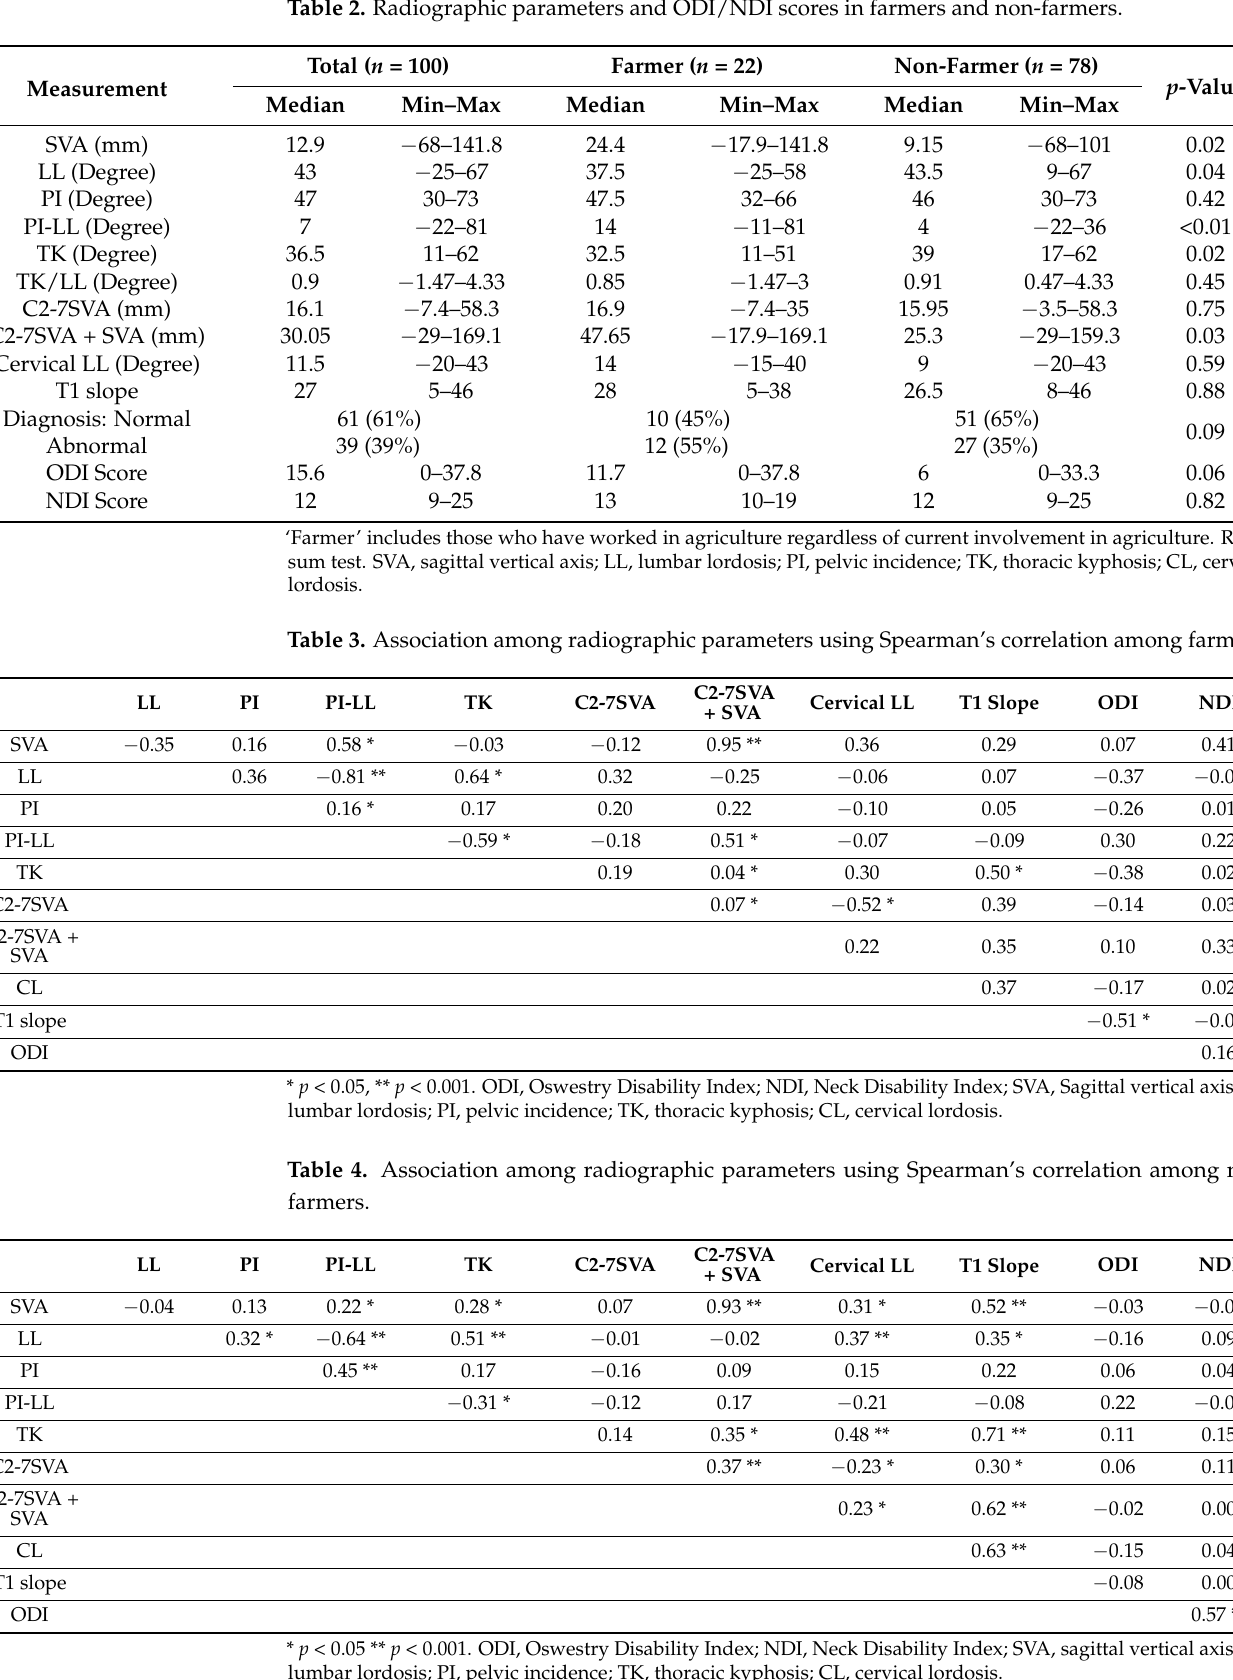
Table 2. Radiographic parameters and ODI/NDI scores in farmers and non-farmers.